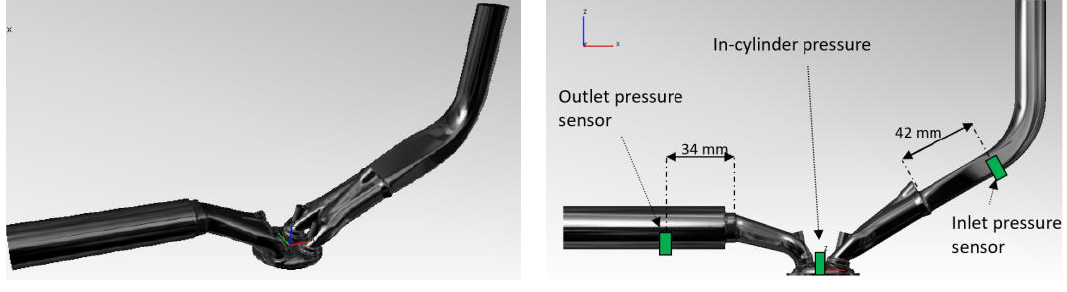
Figure 4. 3D engine geometry.